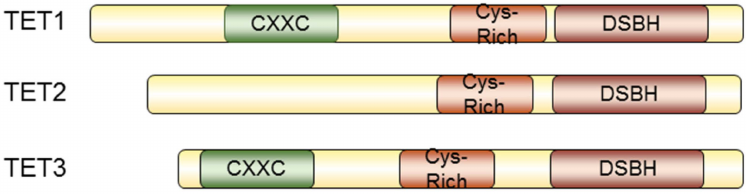
Figure 3. The TET protein family and their structures. Schematic structures of TET1, TET2, and TET3. TET proteins contain a Cys-rich region and a double-stranded helix (DSBH) at the C-terminus. TET proteins require cofactors, such as Fe(II) and 2OG, to hydroxylate substrates. Both TET1 and TET3 proteins contain a CXXC zinc-finger domain at the N-terminus, which can distinguish the methylation status of